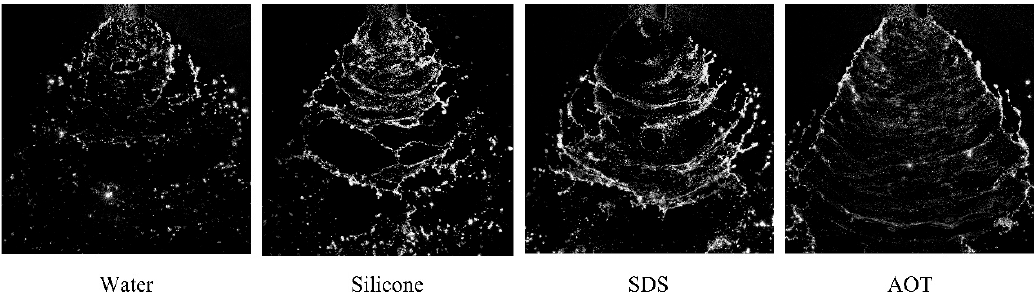
Figure 5. Spray images of AIXR nozzle with water, silicone, SDS, and AOT.